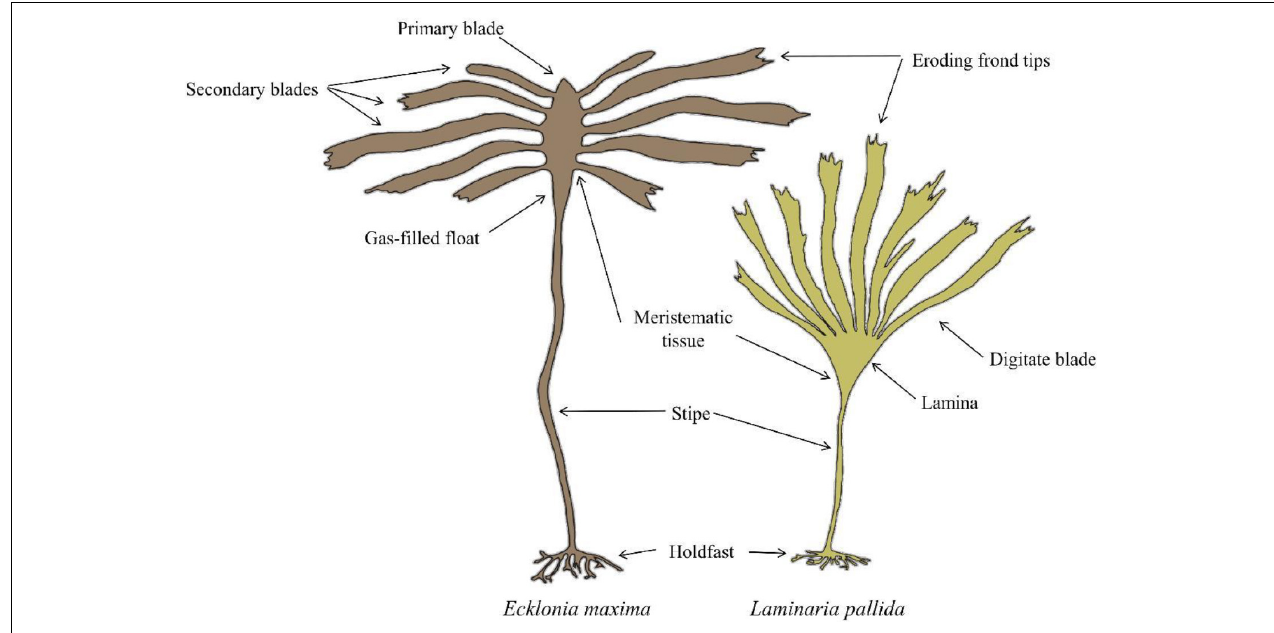
FIGURE 2 | Schematic of Laminaria pallida and Ecklonia maxima morphology (Dyer, 2018).